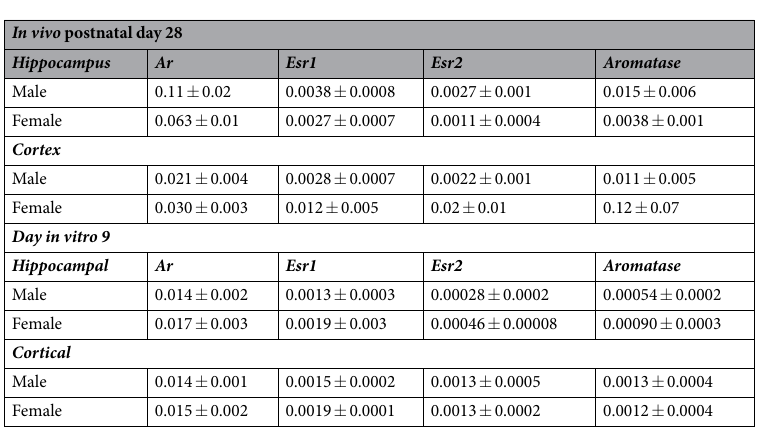
Table 1. Relative mRNA abundance. Results reported as mean ΔΔ Ct ± SEM. Abbreviations: Ar , Androgen receptor; Esr1 , estrogen receptor alpha; Esr2 , estrogen receptor